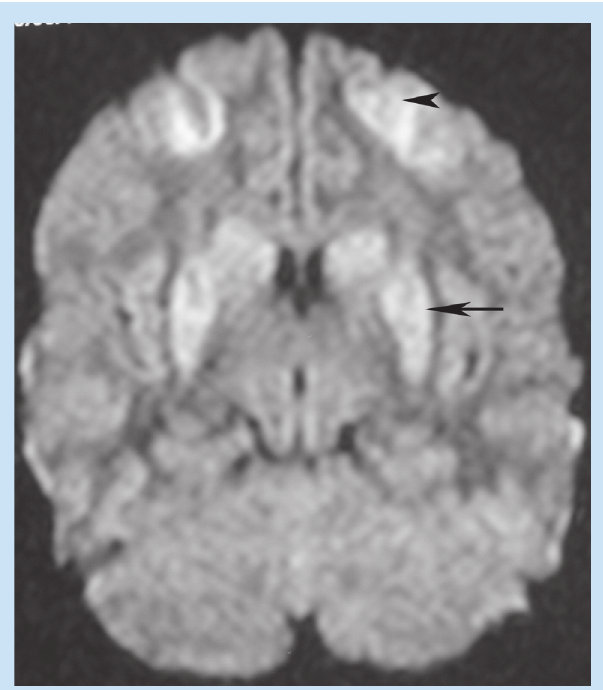
Fig. 2.4e. DWI demonstrates abnormality at the anterior watershed region (arrowhead) bilaterally and in the basal ganglia (arrow) bilaterally due to a global severe hypoxic event.